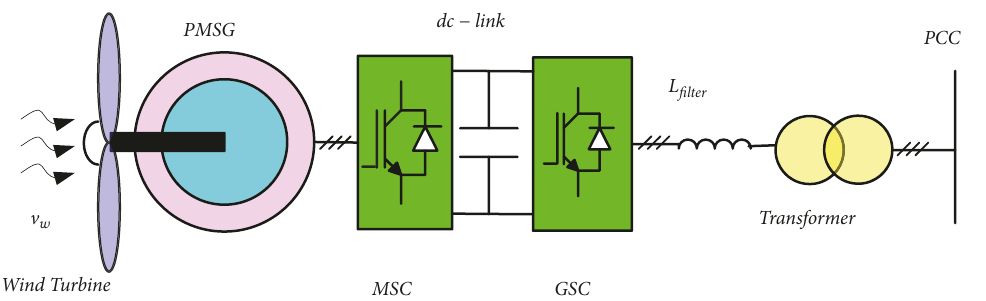
Figure 2: The PMSG-based wind power system